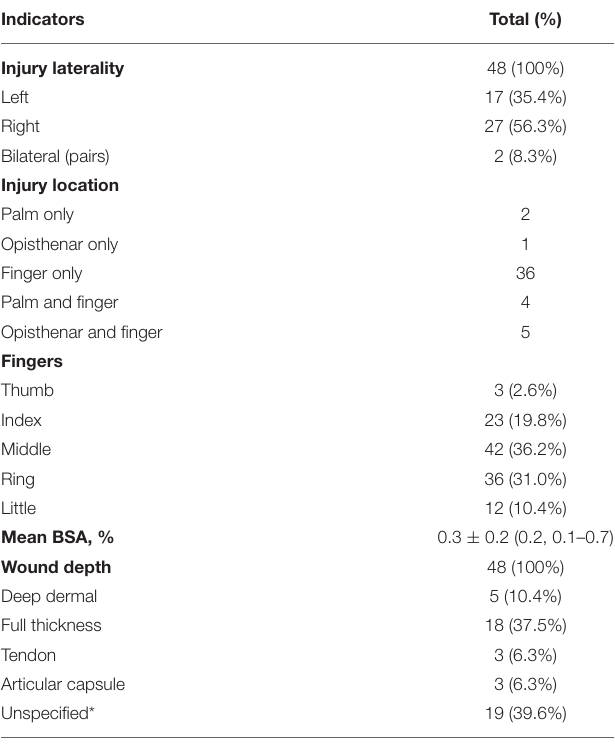
TABLE 2 | Injury details of the involved 48